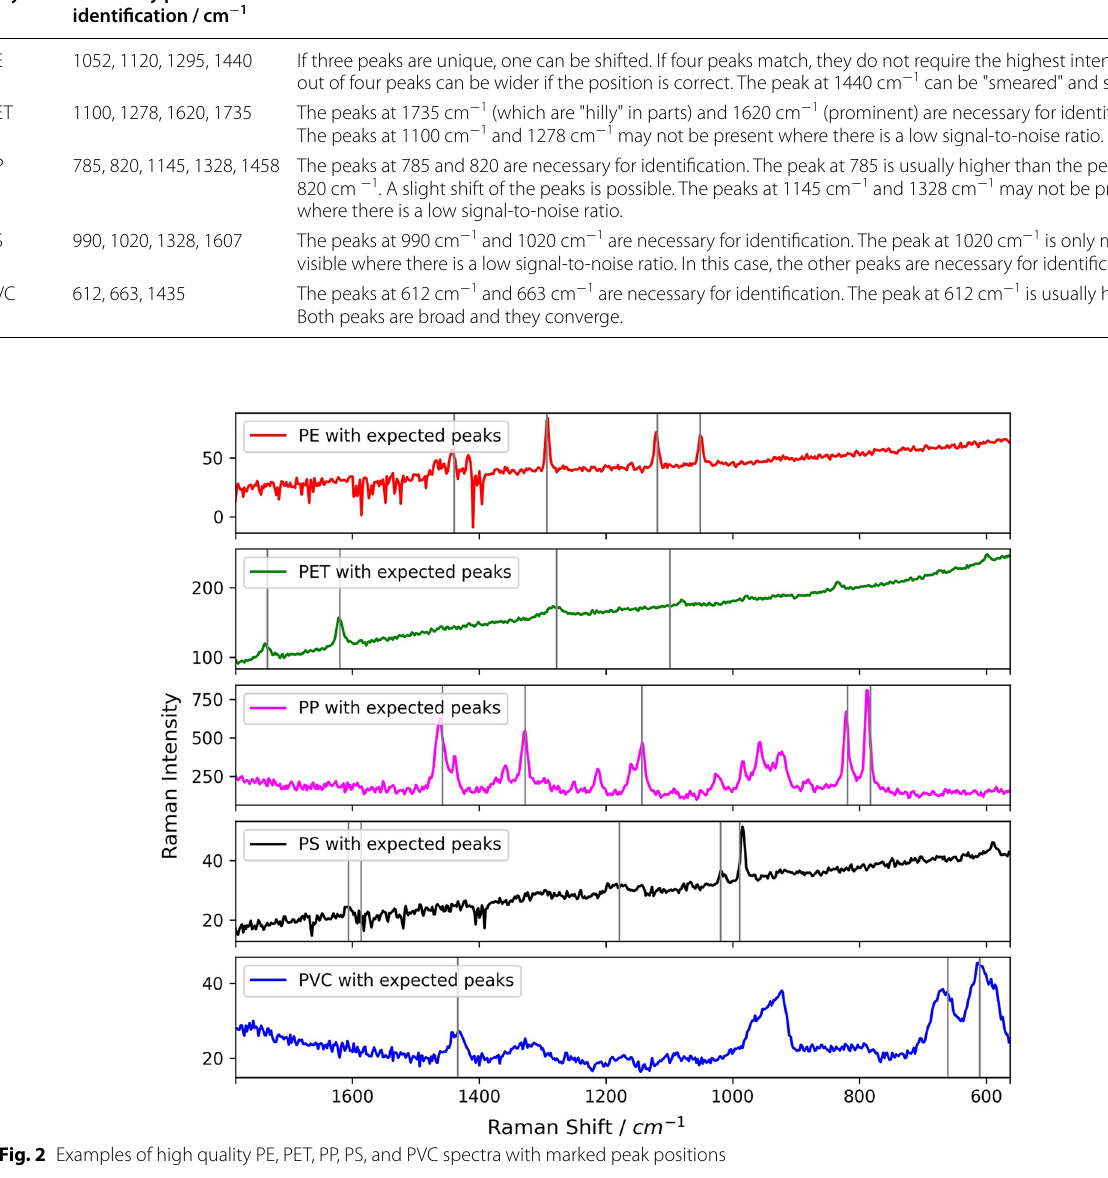
Table 1 Identification criteria and necessary peaks for polymer classification by domain experts Polymer Necessary peaks for Further identification criteria identification / cm − 1